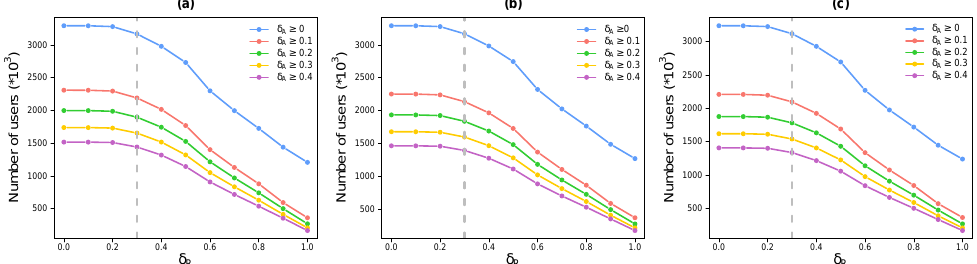
Figure A1. Influence of the parameters. Number of reliable users during the first ( a ), second ( b ), and third ( c ) week as a function of δ R and for different values of δ A . The vertical bars indicate the value δ R = 0.3. Table A1. Number of users (all) and reliable users according to the week of observation and in total. Date # Users